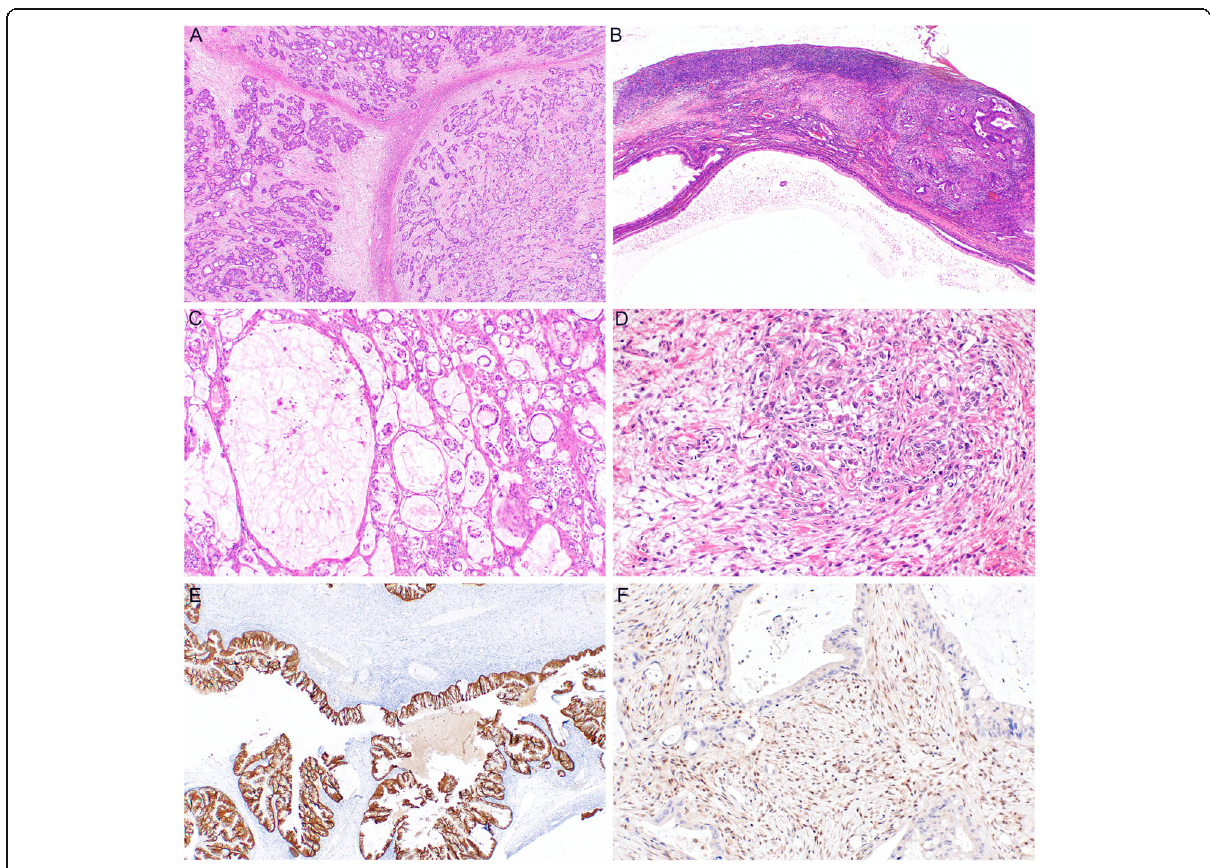
Fig. 3 Ovarian metastases from GIT tumors. Metastasis of colorectal carcinoma showing nodular arrangement ( a ) (H&E, 40x). Metastasis of pancreatic carcinoma with areas of benign appearance and a nodule of infiltrative growth ( b ) (H&E, 40x). Gallbladder metastasis with infiltrative growth of irregular glands ( c ) (H&E, 100x). Metastases of gastric carcinoma with typical appearance of Krukenberg tumor with “ pseudosarcomatous ” stromal reaction ( d ) (200x). Ovarian metastasis of appendiceal low grade mucinous neoplasm showing positivity of cytokeratin 20 ( e ) (40x). Pancreatic metastasis showing loss of DPC4 expression ( f )